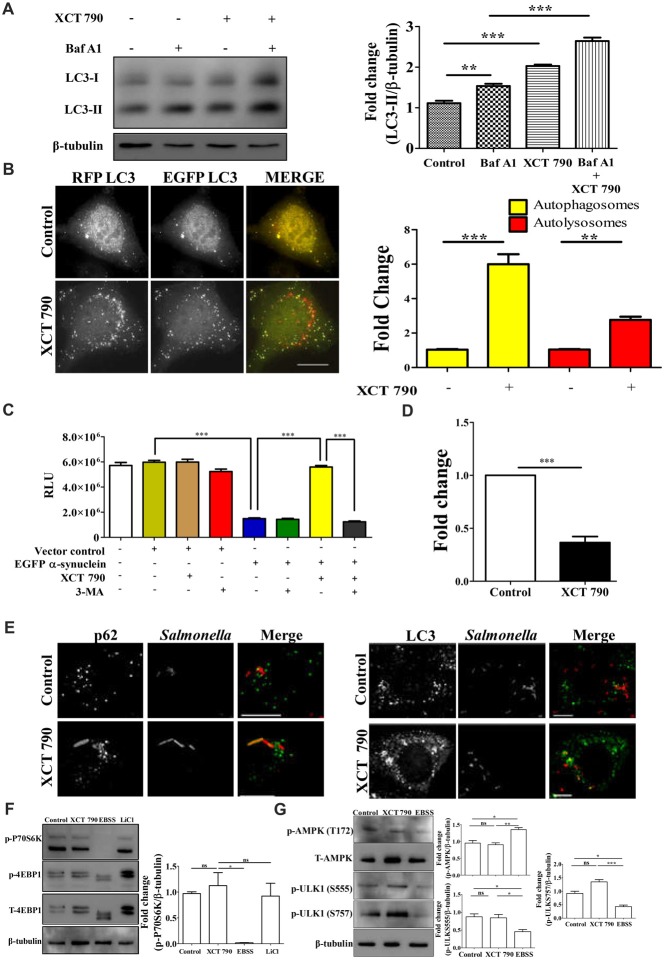
XCT 790 modulates aggrephagy and xenophagy in mammalian cells. (A) Representative Western blot of LC3 processing assay in SH-SY5Y cells treated with XCT 790 (2 h) under growth condition and normalized LC3-II levels were quantified (n = 3). β-tubulin was used as a loading control. Statistical analysis was performed using one-way ANOVA and post hoc Bonferroni test. Error bars, mean ± SEM. ns-non significant, **P < 0.01, ***P < 0.001. (B) Representative microscopy images of tandem RFP-EGFP-LC3 assay in HeLa cells treated with XCT 790 for 2 h. Yellow puncta was autophagosomes and red was autolysosomes. Fold change in autophagosomes and autolysosomes by XCT 790 were quantified (n = 50 cells and three independent experiments). Scale bar was 15 μm. Statistical analysis was performed using one-way ANOVA and post hoc Bonferroni test. Error bars, mean ± SEM. ns-non significant, **P < 0.01, ***P < 0.001. (C) Graph indicating the cell viability read out of SH-SY5Y overexpressing EGFP-α-synuclein treated with XCT 790 in presence of pharmacological autophagy inhibitor 3-MA. Cell viability was analyzed using CellTitre Glo (Promega) assay. More RLU readout was indicative of more cell viability and vice-versa (three independent experiments). Statistical analysis was performed using one-way ANOVA and post hoc Bonferroni test. Error bars, mean ± SEM. ***P < 0.001. (D) Graph for colony forming unit (CFU)s indicating the intracellular burden of S. typhimurium treated with XCT 790 (10 μM) for 6 h. CFU represent survival of S. typhimurium within the host cells. Fold change between the untreated and XCT 790 treated samples were quantified (three independent experiments). Statistical analysis was performed using two-tailed paired t-test. Error bars, mean ± SEM. ns-non significant, **P < 0.01, ***P < 0.001. (E) Representative microscopy images of HeLa cells infected with mCherry expressing S. typhimurium treated with XCT 790 for 6 h. Cells were immunostained for either p62 or LC3 in untreated and XCT 790 treated samples (n = 25 cells and three independent experiments). Scale bar 10 μm. (F) Representative Western blots of MTOR substrates—P70S6K (phospho and total form) and 4EBP1 (phospho and total form)—regulation by various treatments like XCT 790, EBSS and LiCl. β-tubulin was used as a loading control. Normalized p-P70S6K levels were quantified for three independent experiments. Statistical analysis was performed using one-way ANOVA and the post hoc Bonferroni test. Error bars, mean ± SEM. ns-non significant, *P < 0.05. (G) Representative Western blots of signaling pathway proteins like AMPK (phospho and total form) and ULK1 (phospho and total form) regulation by XCT 790 and EBSS. Normalized p-AMPK, p-ULK1 (S555), p-ULK1 (757) levels were quantified for three independent experiments. β-tubulin was used as a loading control. Statistical analysis was performed using one-way ANOVA and the post hoc Bonferroni test. Error bars, mean ± SEM. ns-non significant, *P < 0.05, **P < 0.01, ***P < 0.001.β-tubulin was used as a loading control. Concentrations of XCT 790, 3-MA and LiCl used were 5 μM, 100 nM and 10 mM.